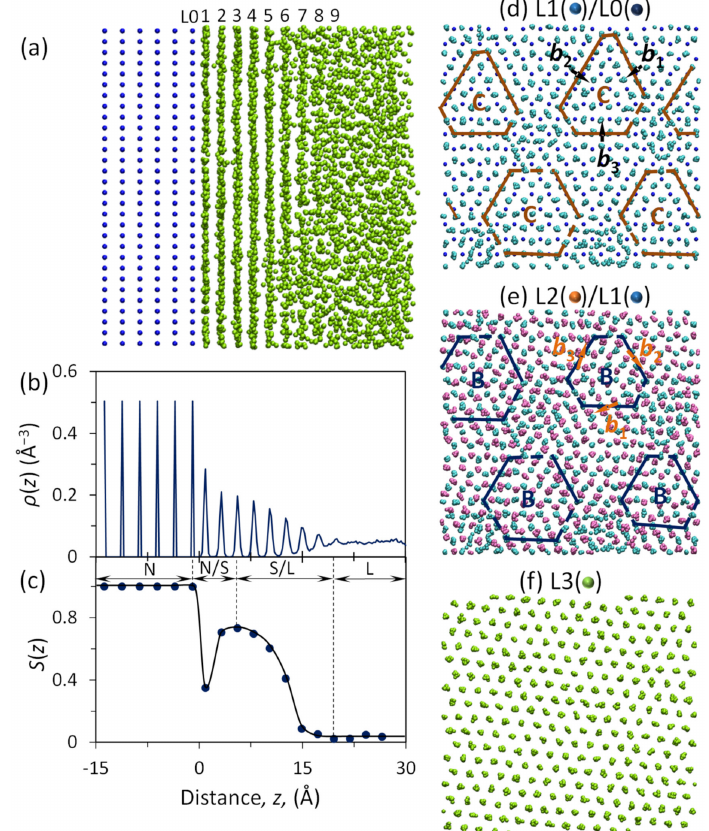
Figure 6. Heterogeneous nucleation produces a 2D nucleus (L3) which is a crystal plane of the new phase [11]. The atomic arrangement at the end of heterogeneous nucleation ( t = 50 ps) in the simulation system with − 8% misfit at T n = 760 K. ( a ) A snapshot, and ( b ) the quantified atomic density profile, ρ ( z ), and ( c ) in-plane atomic order parameter, S ( z ), as a function of the distance, z , from the substrate surface ( z = 0 Å). Time-averaged atomic positions in ( d ) L1 on top of L0 (substrate surface) showing the partial edge dislocation network; ( e ) L2 on top of L1 showing the partial screw dislocation network; and ( f ) L3 showing the 2D nucleus which is a plane of the new phase ({111} of Al). b 1 , b 2 , b 3 and the arrows represent the Burges vectors of the Shockley partial dislocations in L1 and L2. B and C in ( d ) and ( e ) represent the stacking sequence of